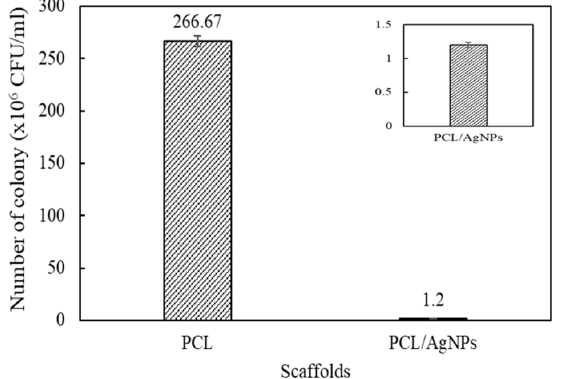
Figure 12. Antibacterial testing result of scaffolds using total plate count (TPC) method. As can be seen in Figure 12, the number of surviving bacterial colonies in the PCL scaffolds and the PCL/AgNPs scaffolds are 266.7 ± 5.1 × 10 6 CFU/mL and 1.2 ± 0.04 × 10 6 CFU/mL respectively. Thus, the addition of 0.5 wt.% AgNPs to the scaffolds significantly reduces the number of surviving bacterial colonies to only 0.5% of surviving bacteria after 24 h incubation, highlighting the PCL/AgNPs scaffold’s excellent antibacterial activity. 2.3. AgNPs Production and Scaffold Fabrication Discussion The development of a green synthesis method using biological entities, including plant extract as reducing and capping agent, has opened up the possibility of generating minimally toxic AgNPs via a simple, cheap and environmentally friendly method. This work has reported the creation of AgNPs by green synthesis approach using the extract of Cilembu sweet potato as a green mediator. The obtained AgNPs were successfully uti- lized as filler materials in PCL/AgNPs electroactive and anti-infection bone scaffold that was fabricated by 3D printing method. Previous demonstrations of green synthesized AgNPs using potato extract by Roy et al. resulted in spherical AgNPs with 10–12 nm diameter [50], which is further confirmed by Hileuskaya et al., reporting generation of spherical AgNPs with 8–28 nm by using pec- tin [22]. These results are in line with our findings, particularly AgNPs from the Baked 10 sample as our optimal sample, which has spherical shape with comparable particles size of ~9.95 nm. The comparatively small size of the synthesized AgNPs may be attributed to the high maltose content as reducing agent and the necessary capping agents’ presence in the extract of baked Cilembu sweet potato. Previous reports showed that AgNPs with spherical shape [19,54] and small particle size [22,36], especially when the size is less than 10 nm [19], have superior antibacterial activity. Thus, it could be predicted that AgNPs from the Baked 10 sample have excellent antibacterial properties, which is implied from the high antibacterial activity against S. aureus as infection-causing model bacteria. How- ever, more studies are needed to assess its antibacterial activity against other strains of bacteria. Even though our AgNPs show high antibacterial activity against S. aureus , their an- timicrobial mechanism remains unclear. There are several antibacterial actions of AgNPs that have been reported in the literature, the first of which are that AgNPs could attach and penetrate the bacterial cell membrane, leading to direct damage of the cell membrane [19,22,36,49]. Also, it is well known that silver nanoparticles can undergo oxidative disso- lution when exposed to H 2 O 2 or O 2 ,—which can be found inside bacterial cell mem- branes—generating silver ions in vivo. It is hypothesized that the generated Ag + can in- teract with several different components in bacterial cells to induce cellular destruction (i.e., by binding with thiol group-containing respiratory enzyme, transport protein, and DNA, among others) [19,49]. Considering that deeper insight about antibacterial mecha- nism of our AgNPs is important for their application, further studies are essential to eval- uate antibacterial mechanisms of our AgNPs.